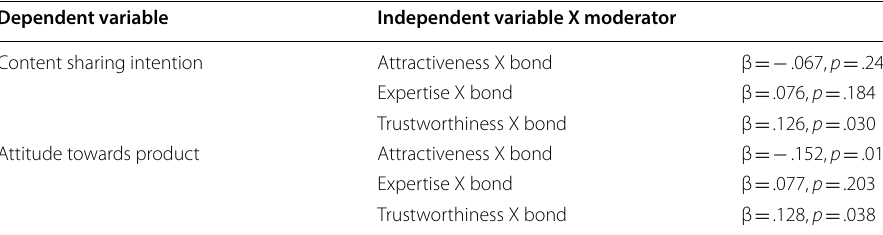
Table 9 Moderated regression analysis